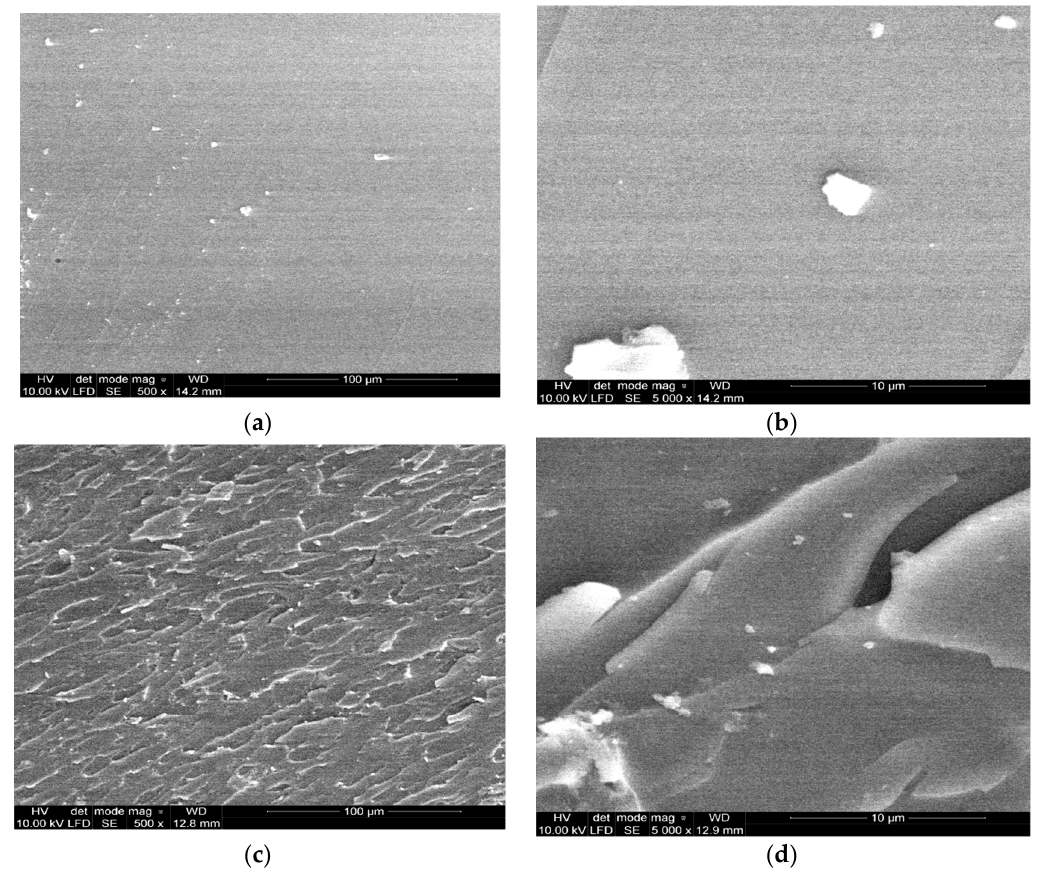
Figure 6. SEM micrograph of the fracture surface of EP0 ( a , b ) and EP modified with 1% NC ( c , d ).